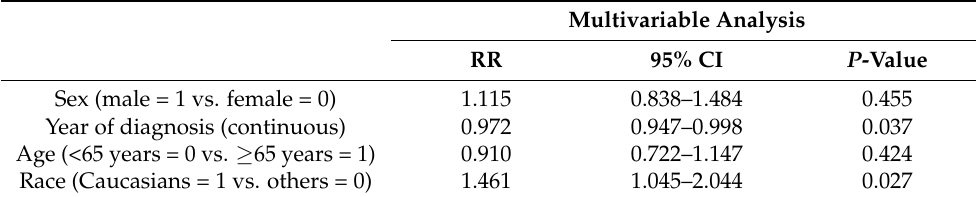
Figure 2. The proportion of esophageal adenosquamous carcinoma over time in the 44,948 patients with esophageal cancer. Table 3. The results of multivariable logistic regression